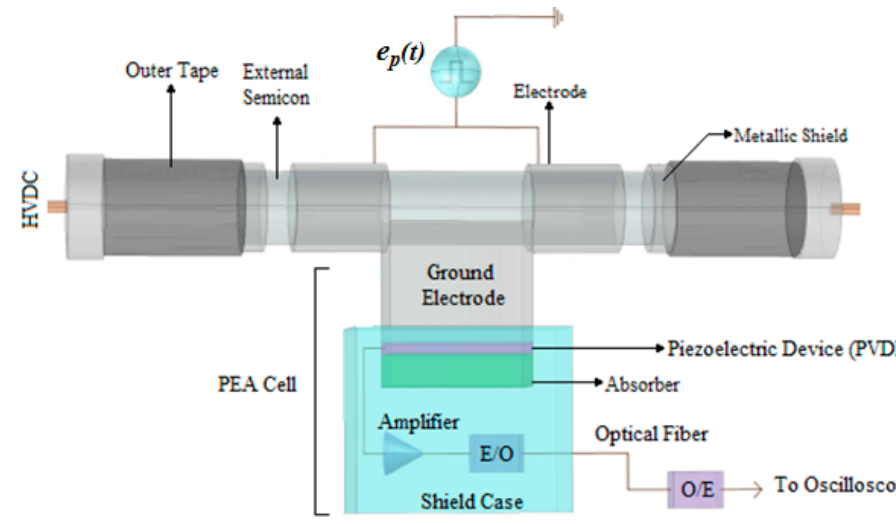
Figure 3. Pulsed electro-acoustic (PEA) measurement setup for space charge measurement in cables.